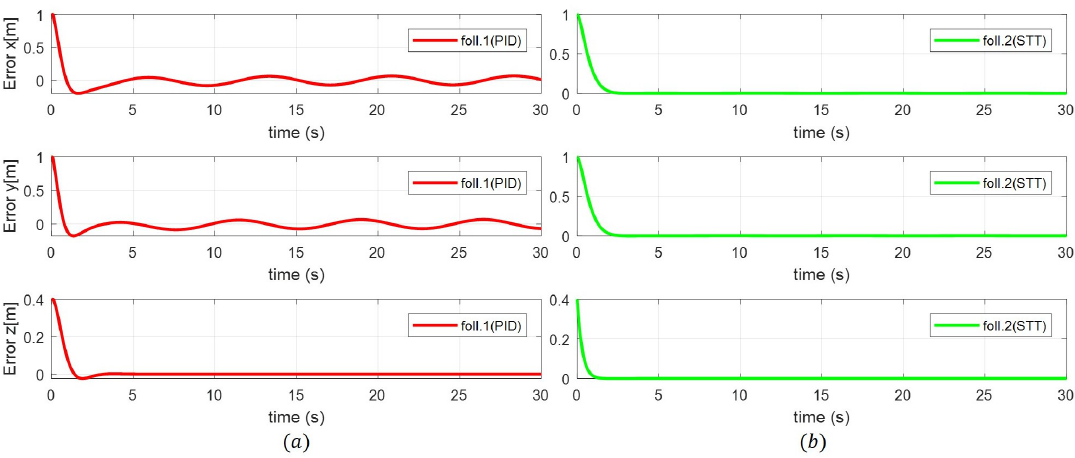
Figure 13. The formation errors for each of the three axis about the 8 π circular trajectory: ( a ) PID control method; ( b ) proposed formation control method in this